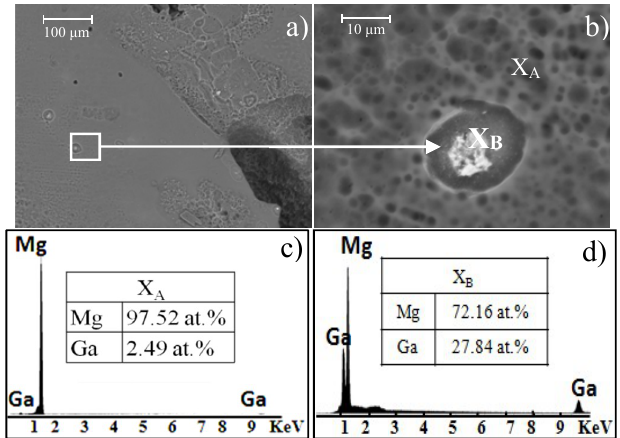
Figure 12. SEM images of the topography of ( a ) as-cast Mg-1.5Ga after 504 h of immersion in SBF, ( b ) close-up of pitting adjacent to Mg 5 Ga 2 precipitate, ( c ) EDS analysis X A zone, ( d ) EDS analysis of X B zone.